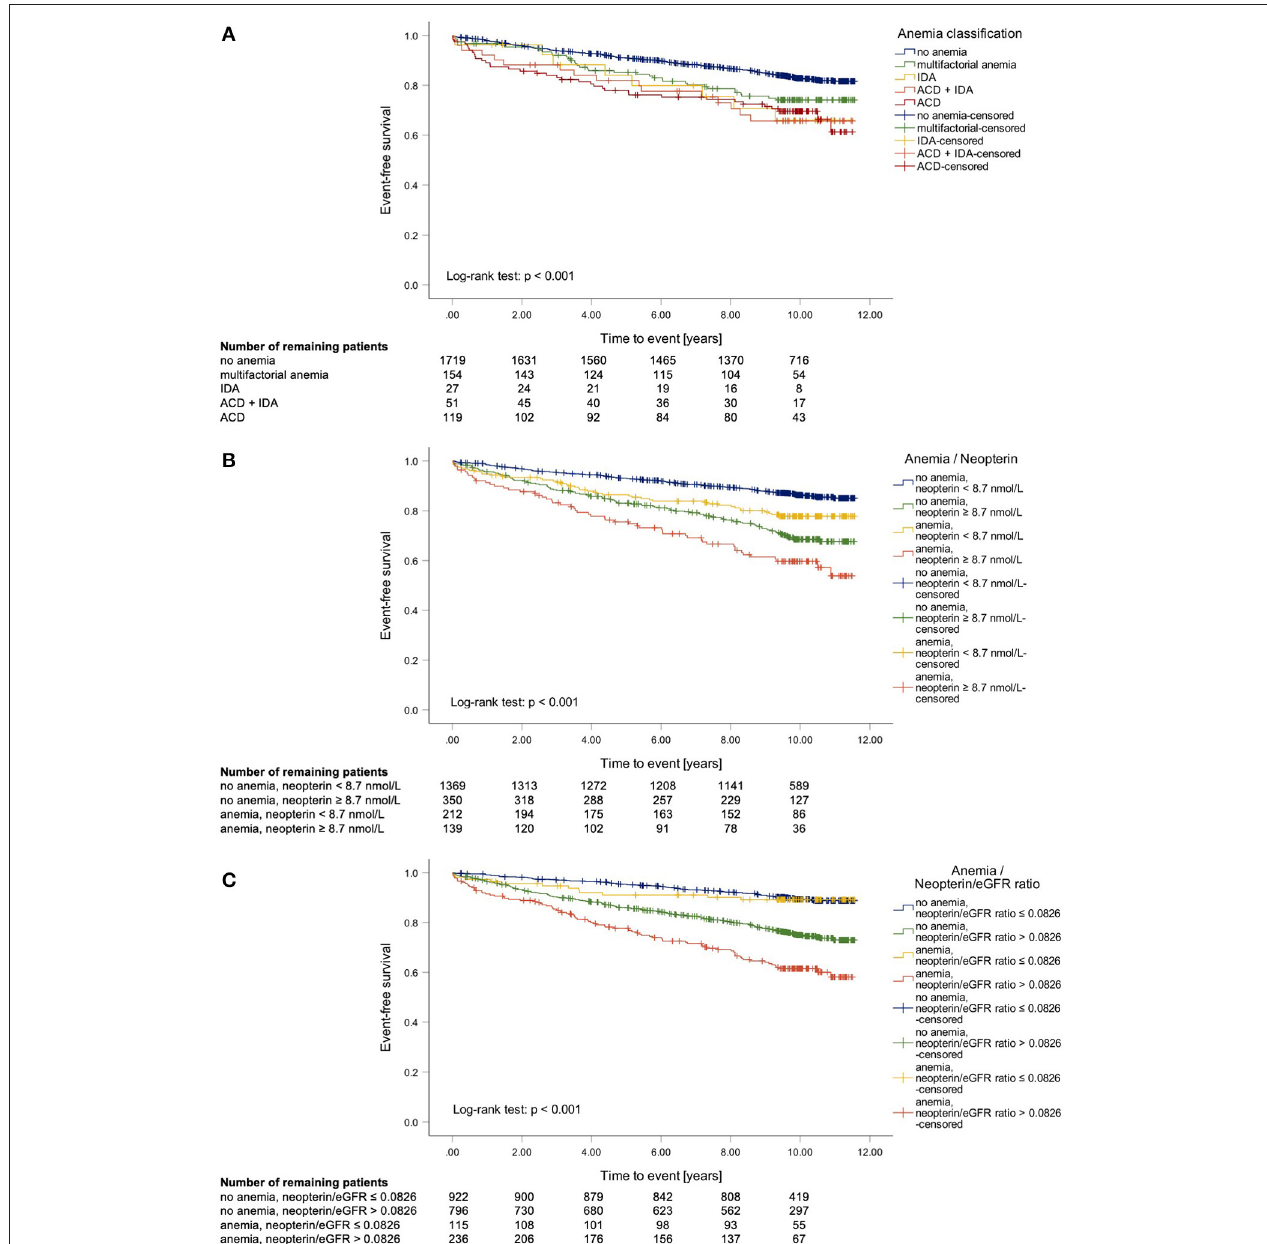
FIGURE 4 | Kaplan-Meier curves of cardio-cerebrovascular (CCV) mortality in terms of the anemia subdivision into anemia of chronic disease (ACD) and iron deficiency anemia (IDA) (A) and Kaplan-Meier curve of CCV mortality in terms of anemia and elevated neopterin levels [ ≥ 8.7 nmol/L; (B) ] or respectively neopterin/eGFR ratio [ > 0.0826; (C)